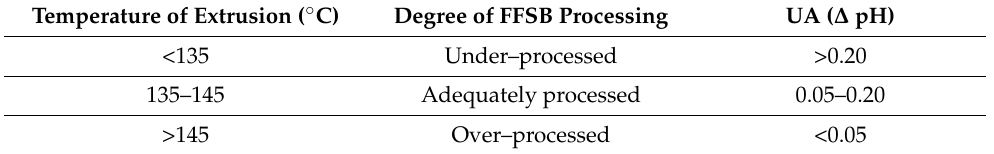
Table 5. Relation between the Temperature of Extrusion, Degree of FFSBM Processing and Urease